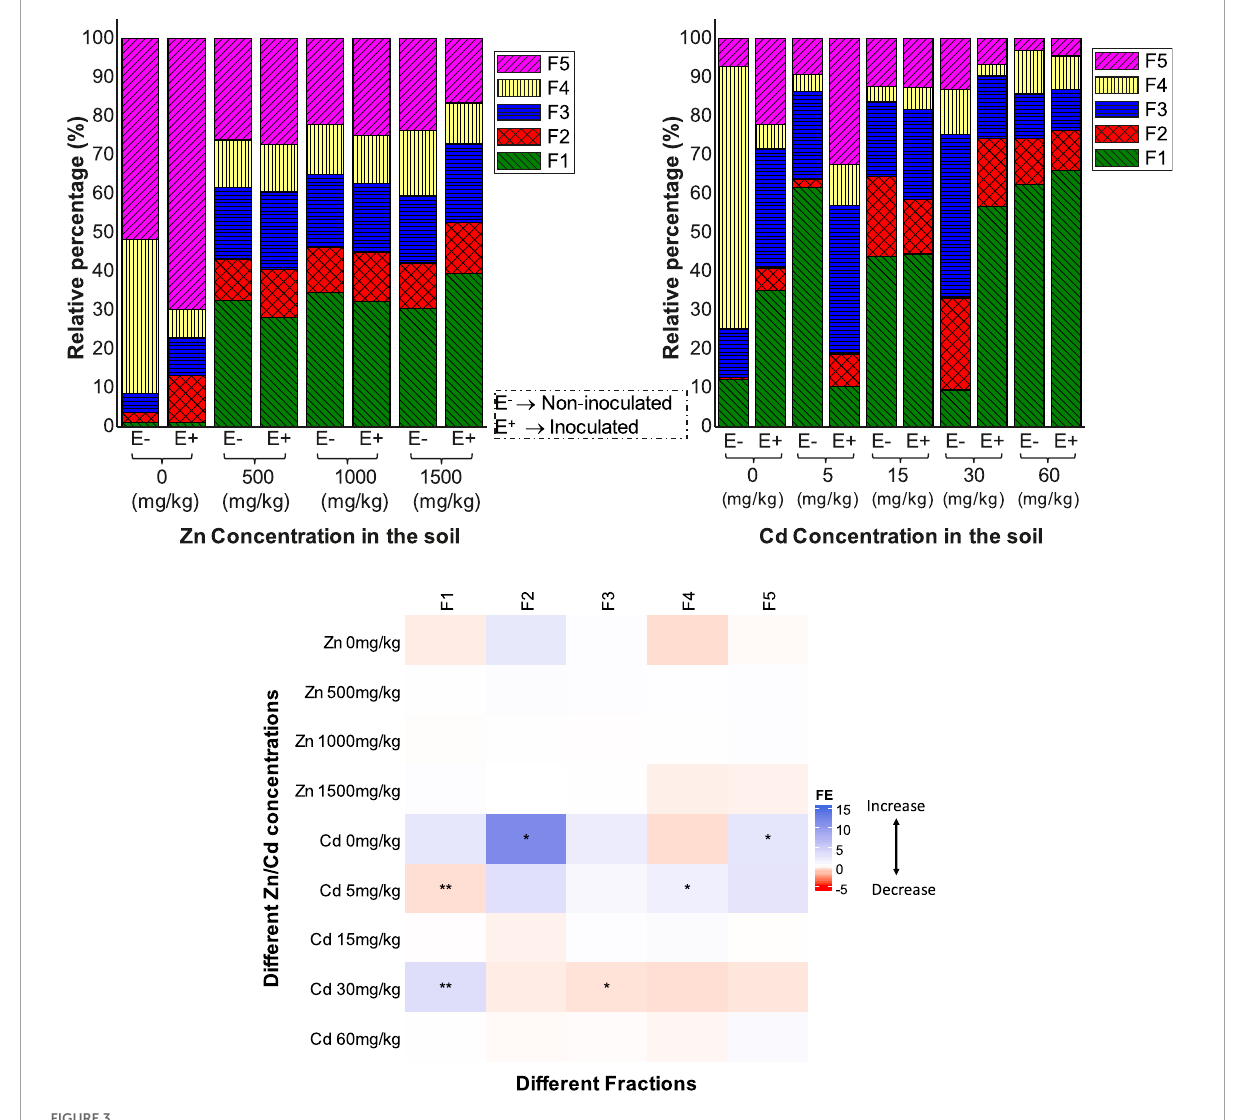
FIGURE3 The effect of FXZ2 inoculation (FE) on the chemical forms of Zn/Cd in rhizospheric soils of Dysphania ambrosioides under Zn/Cd stress. F1: exchangeable fraction; F2: carbonate-bound fraction; F3: Fe-Mn oxides bound; F4: organic bound fraction; F5: residual fraction. The asterisks indicate a significant difference between F E + and F E − (* p < 0.05, ** p < 0.005, t